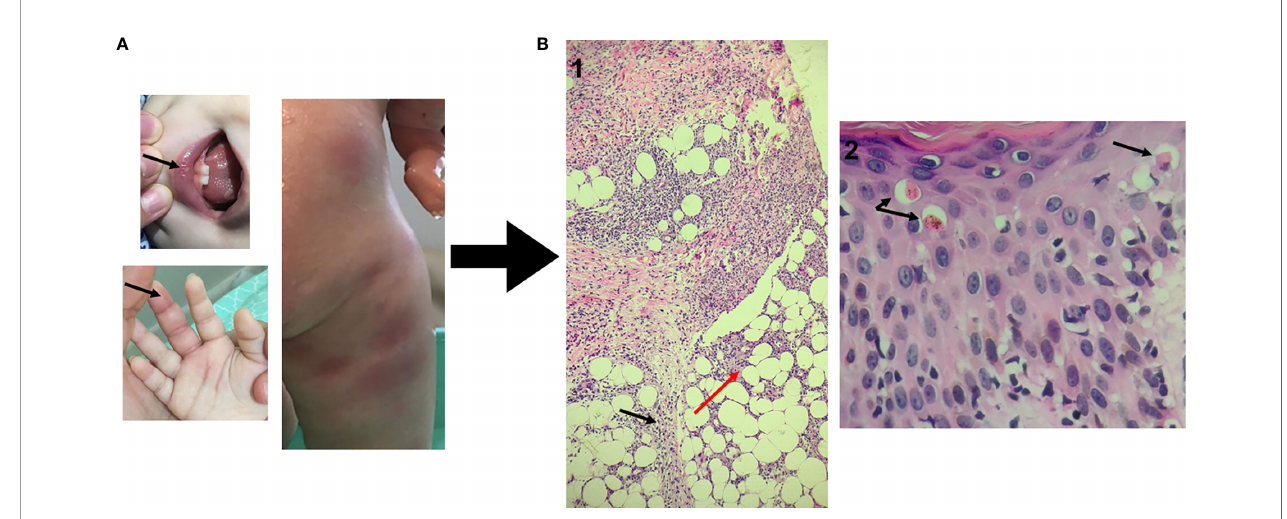
FIGURE 1 | Dermatological and histopathological fi ndings. (A) - Oral ulceration and dactylitis (black arrows) and skin rash observed during fever fl ares resembling erythema nodosum. (B) Hematoxylin-eosin staining of skin biopsy (punch) previously fi xed in 10% neutral buffered formalin. 1 - (100x magni fi cation): Septal panniculitis (black arrow) with foci of in fl ammatory cells extending into adjacent fat lobule (red arrow). 2 - (400x magni fi cation): epidermal spongiosis and lymphocyte exocytosis with dyskeratotic cells (arrow) and interface dermatitis with vacuolar changes in the basal